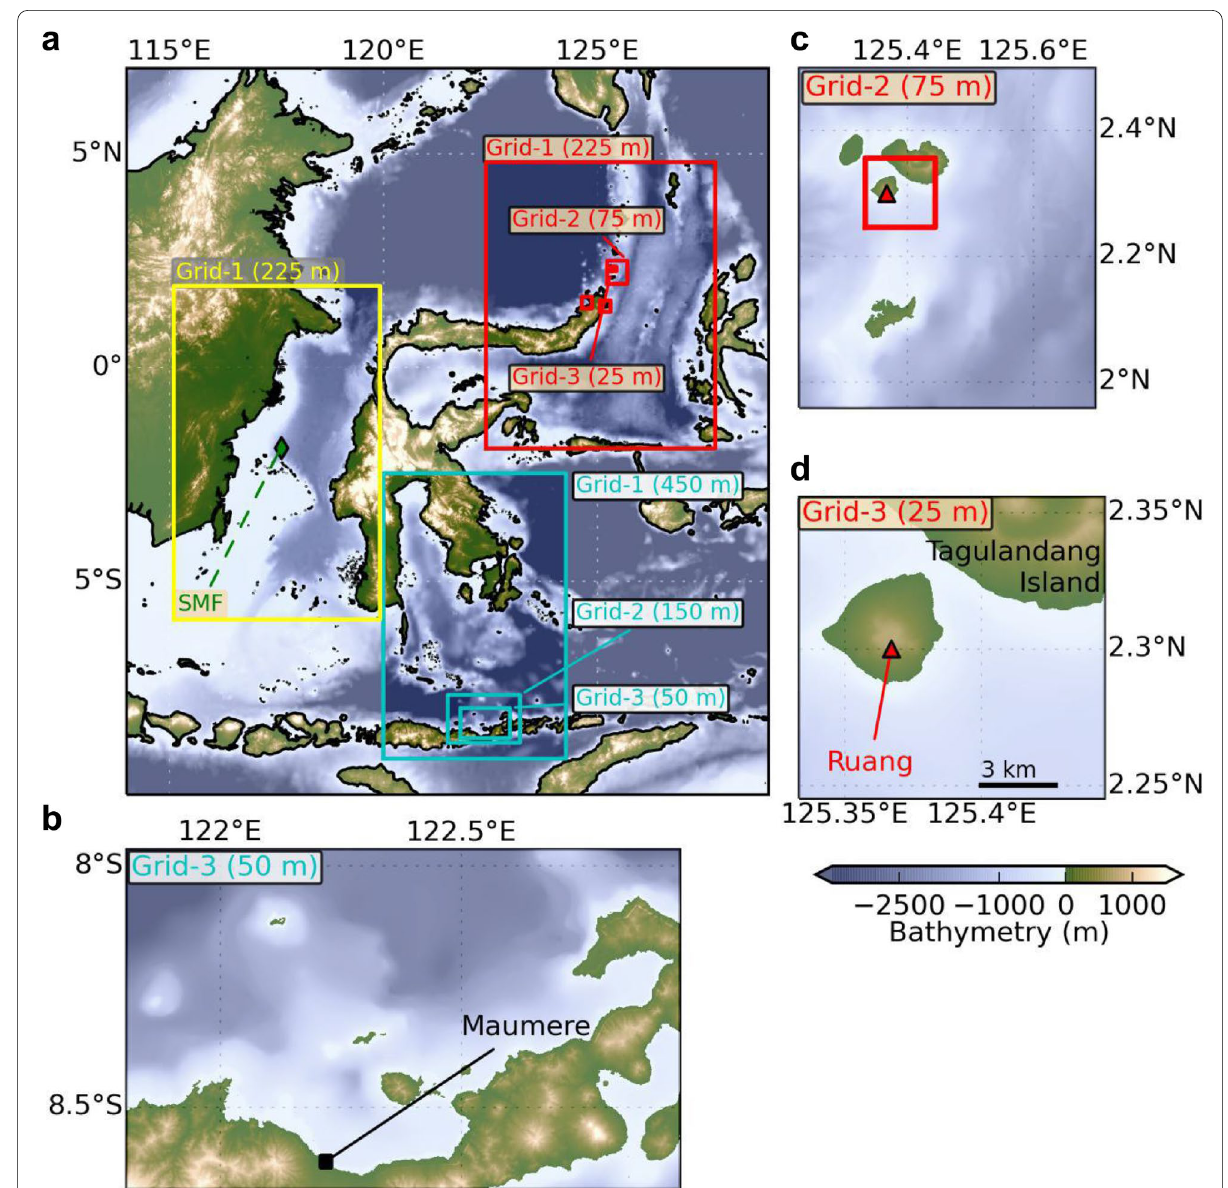
Fig. 3 Map of a digital elevation model (DEM) for tsunami modelling and its domain model. b DEM at Grid-3 for tsunamigenic earthquake scenario, c and d DEMs at Grid-2 and Grid-3 for the volcano-tsunami models,